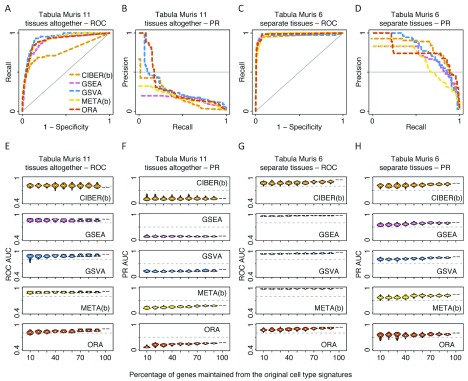
Performance and robustness analysis of cell type prediction methods using Tabula Muris scRNA-seq data.The same procedure as described in
Figure 2 for ROC and PR AUCs of the liver and retinal neuron datasets was used here for the Tabula Muris dataset. Please see
Figure 2 legend for details. The Tabula Muris dataset was analysed in two ways. In the first way (‘Tabula Muris 11’, panels
A,
B,
E and
F), 11 tissues whose cell type signatures and cell clusters could be mapped against each other were analysed using all cell type signatures as a single input gene set database for cell type prediction methods. In the second way (‘Tabula Muris 6’, panels
C,
D,
G and
H), the analysis was restricted to six tissues with three or more cell type signatures. In this strategy, each tissue’s cell types were predicted separately from other tissues and the results were combined afterwards to evaluate the ROC, PR and robustness of each of five automated cell type prediction methods: CIBERSORT (CIBER(b)), GSEA, GSVA, METANEIGHBOR (META(b)) and ORA.